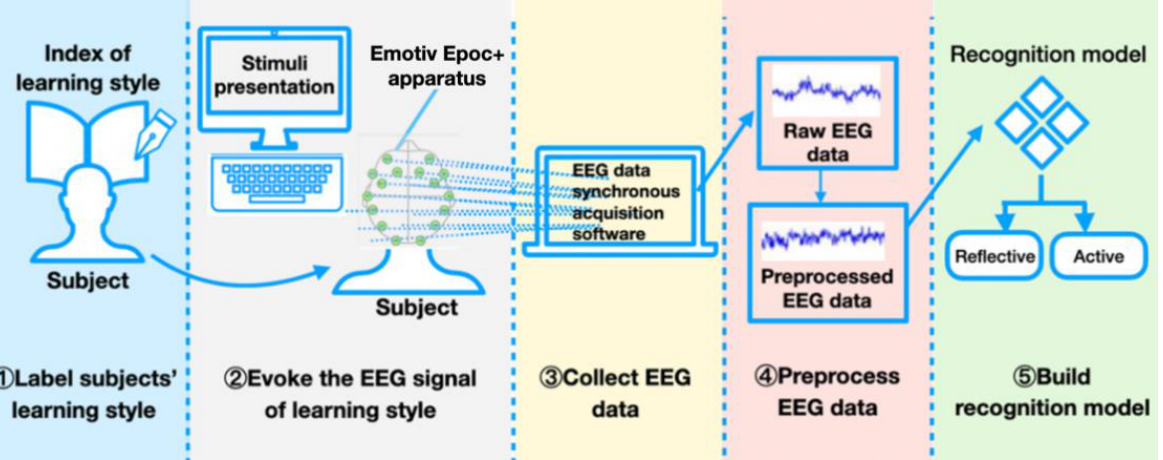
Figure 2. Procedure of experiment to recognize learning styles.